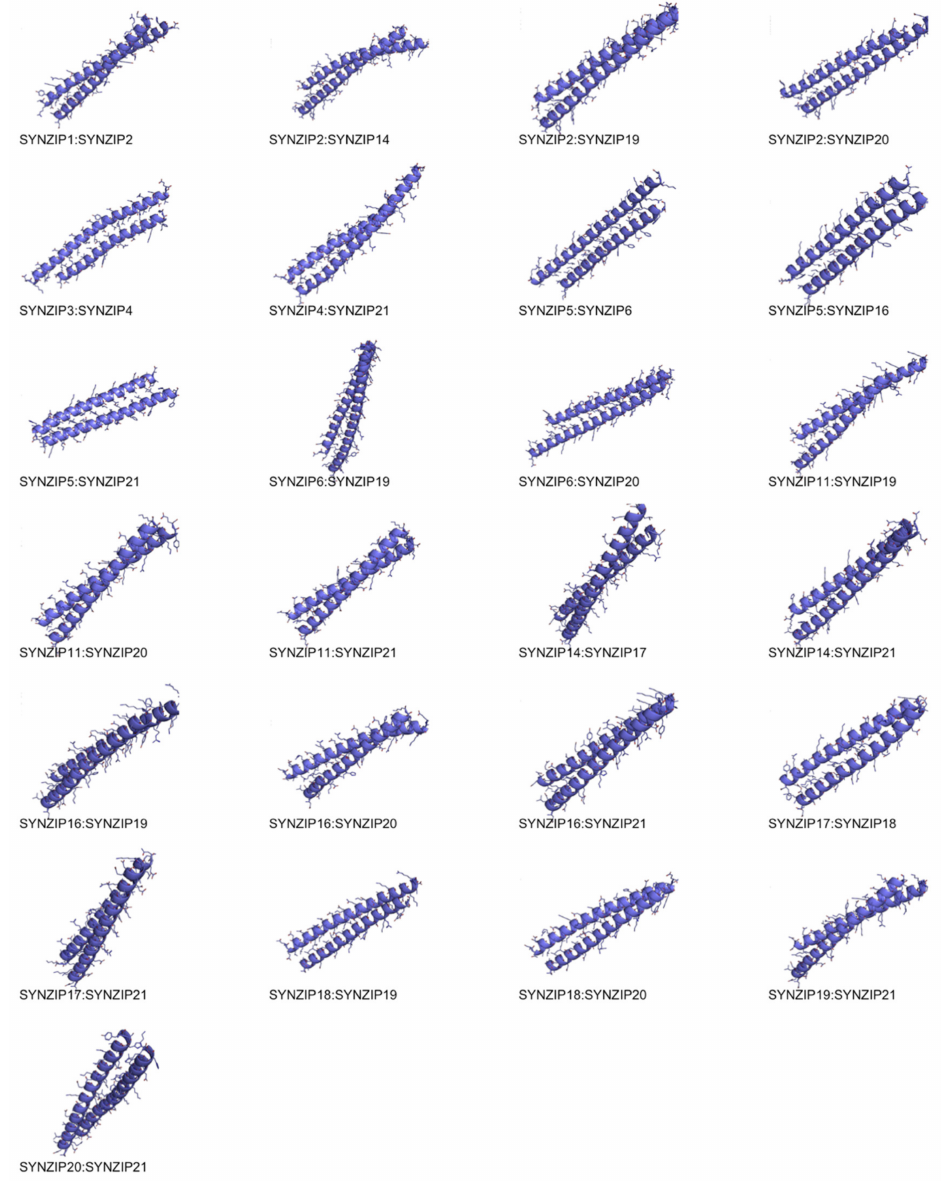
Figure 3. Lowest energy models for the highest affinity coiled coils indicating well-formed